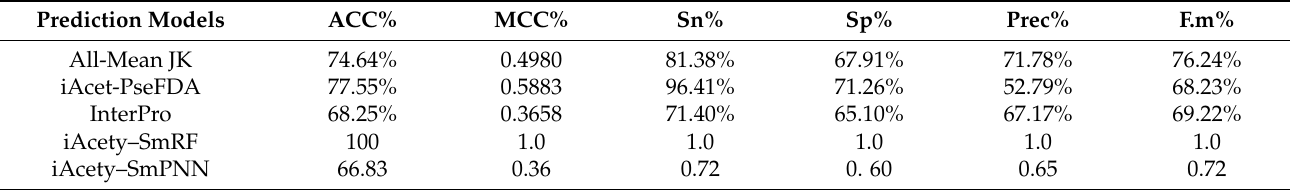
Table 11. Comparative analysis of the proposed acetylation model with the existing